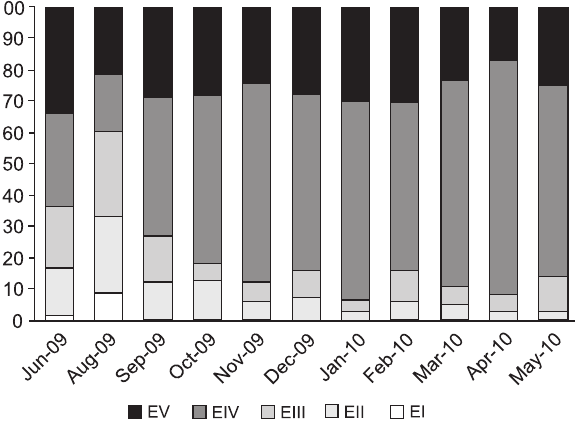
Figure 4. Distribution e frequency of gonadal development stages of Scolelepis goodbodyi . Stage I: initial development; stage II: pro- liferation; stage III: immature; stage IV: mature; stage V: partial release of gametes.